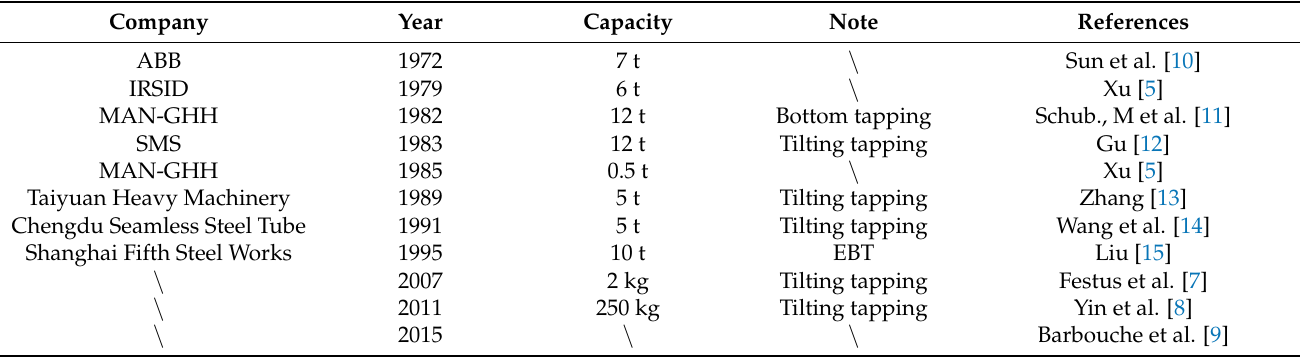
Table 1. Comparison of the tapping methods in Previous